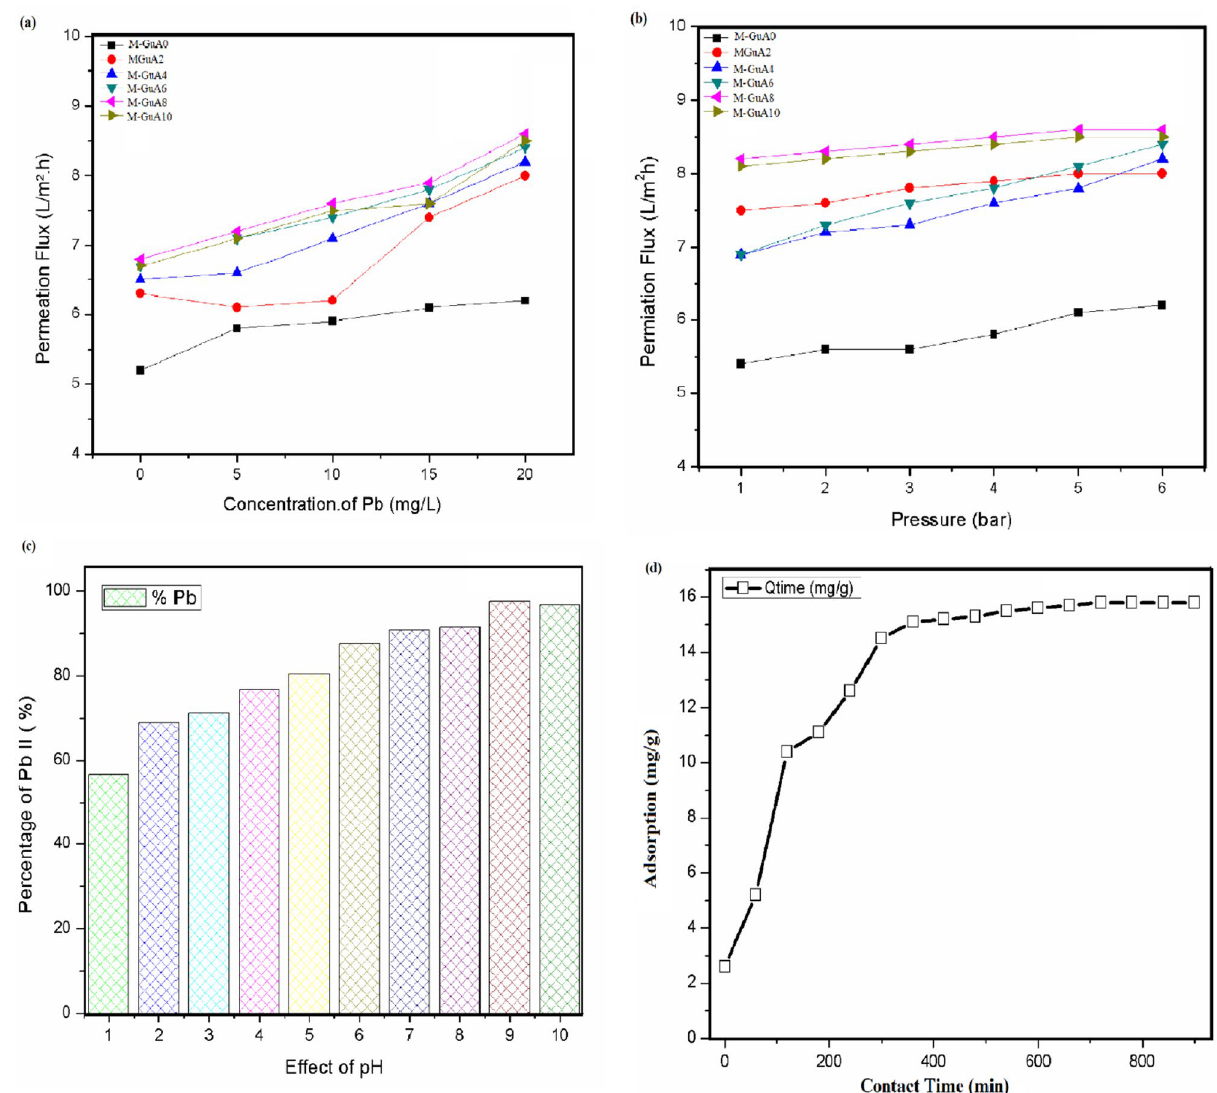
Figure 6. Effect of ( a ) concentration and ( b ) pressure on permeation of Pb(II), ( c ) Effect of pH on Pb(II) rejection, ( d ) Effect of contact time on adsorption of